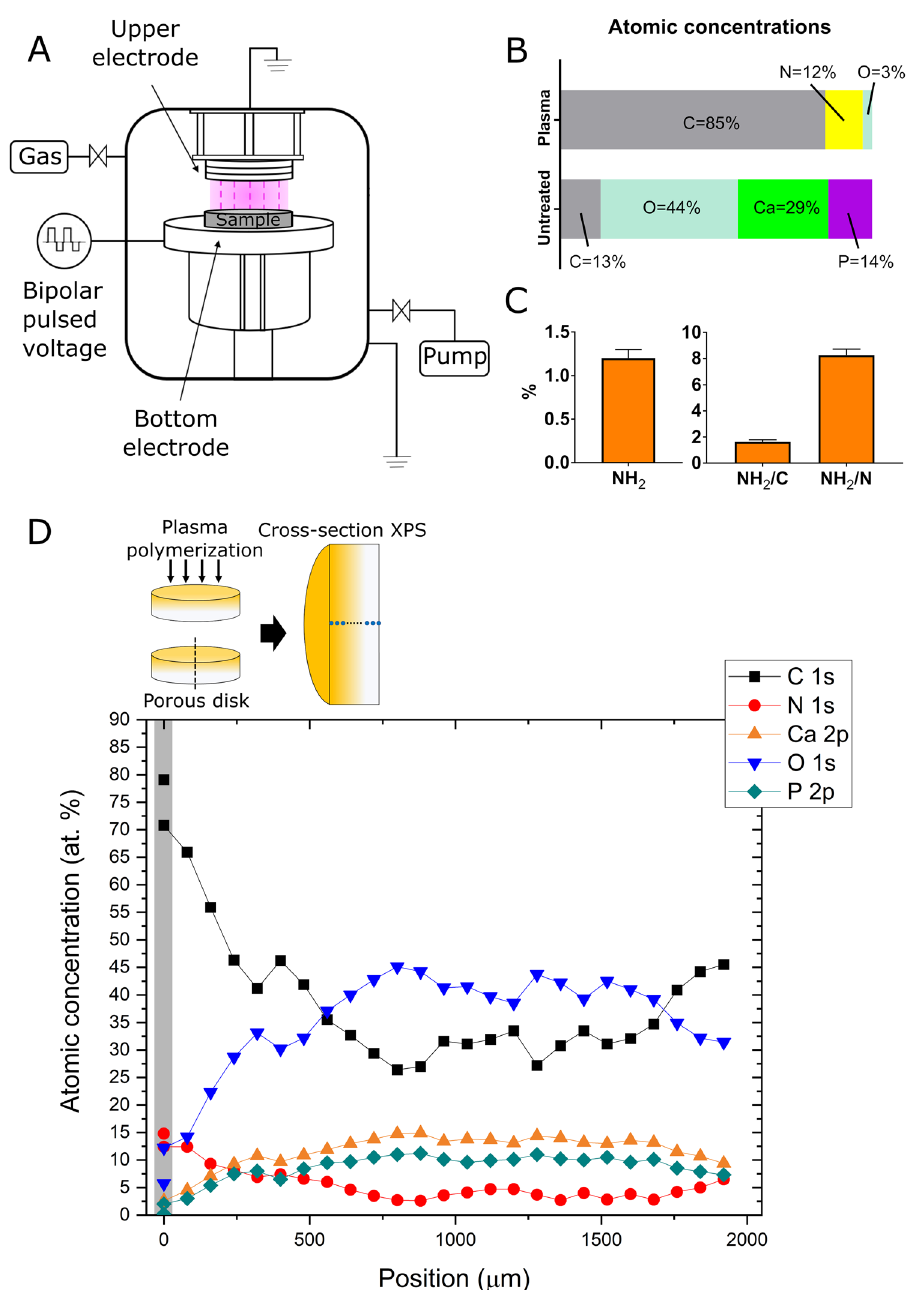
Figure 1. Plasma polymerization system and characterization of plasma-polymerized films. ( A ) Schematic diagram of the pulsed-plasma deposition system used in this study. Samples were placed on the bottom metal electrode, which was powered by high-voltage bipolar pulse voltages with a peak-to-peak voltage of 2.2 kV. The power, repetition frequency, and duty cycle were 15 W, 5 kHz, and 1%, respectively. The plasma was generated from a gas mixture of CH 4 , N 2 , and He with flow rates of 10, 20, and 10 sccm, respectively, and a gas pressure of 70 Pa. ( B ) The atomic concentration ratios on a plasma-treated dense β-TCP disk surface (top) and those on an untreated dense β-TCP disk surface (bottom). More precise values are given in the main text. ( C ) The relative number of primary amines (–NH 2 ) among all atoms excluding hydrogen (left) and the number ratios of primary amines to C or N atoms (right) on the surface of the plasma-polymerized film deposited on a dense β-TCP disk. In ( B , C ), all measurements were triplicate. ( D ) The profiles of relative atomic concentrations along the center axis of a plasma-treated porous β-TCP disk, indicating plasma polymerization of the inner pore surfaces due to the penetration of plasma-generated deposition precursors through the interconnected pores from the plasma-treated disk surface. After a single side of a porous β-TCP disk was plasma-treated, it was cut in half through its center and the relative atomic concentrations were measured at 25 points along the center axis. The horizontal axis of the figure represents the position along the center axis measured from the plasma-exposed top surface of the disk. In each case above, the plasma treatment time was 30 min. Schematic diagrams ( A and the top part of D ) were drawn using Microsoft PowerPoint